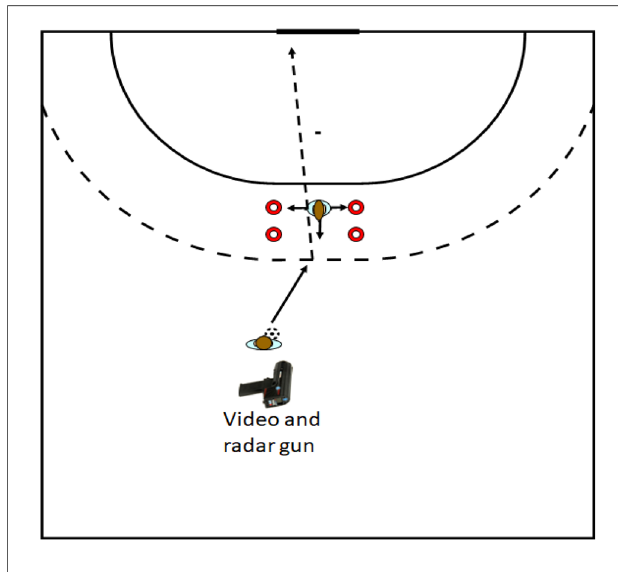
FIGURE 1 Experimental set up where participant performs a jump shot from 9 m distance with a defender (conditions 2 – 4) trying to block the shots with measuring